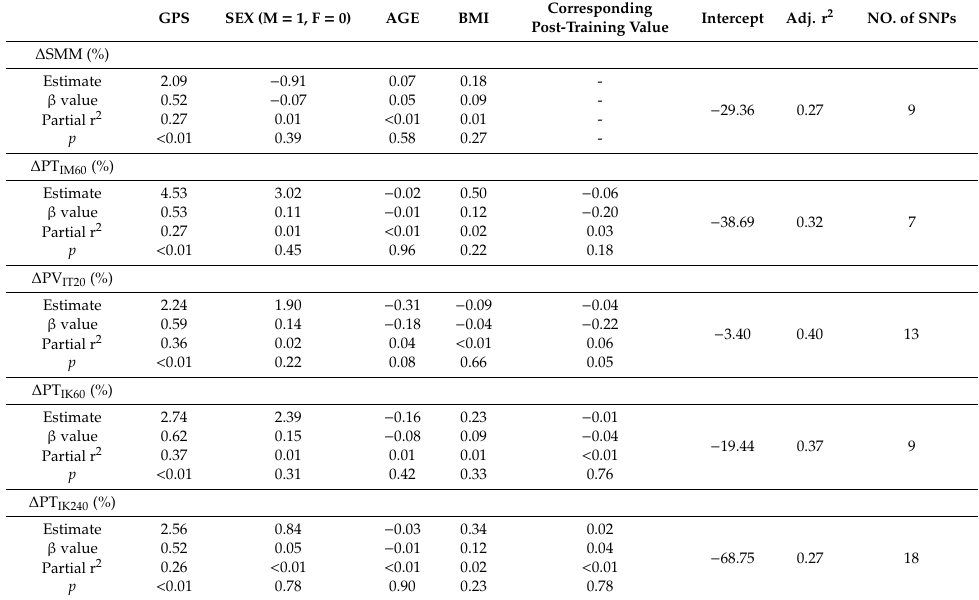
Table 2. Regressions of data-driven genetic predisposition scores (GPSs) and relative muscular changes after one-year cessation of structured